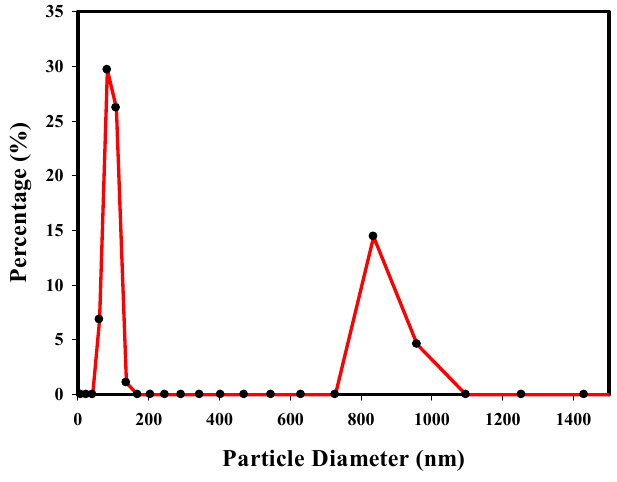
Figure 1. Particle Size Distribution of